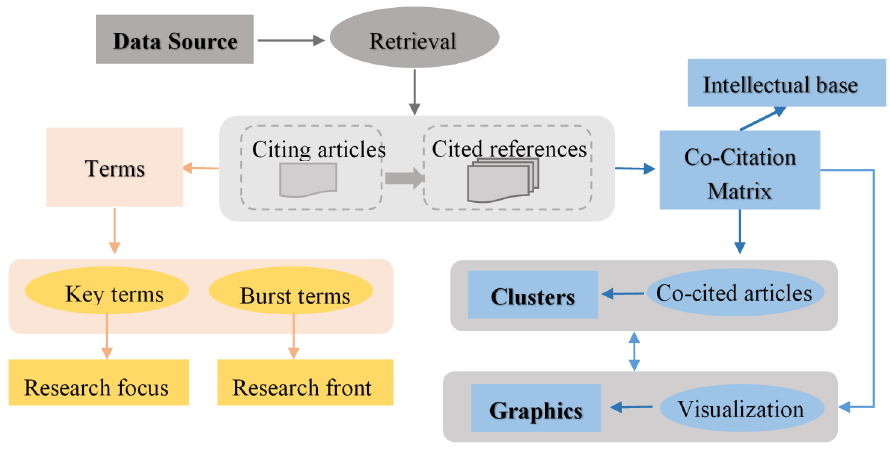
Figure 1. Analytical framework (adapted based on Chen, 2006; 2010 [11,12]).